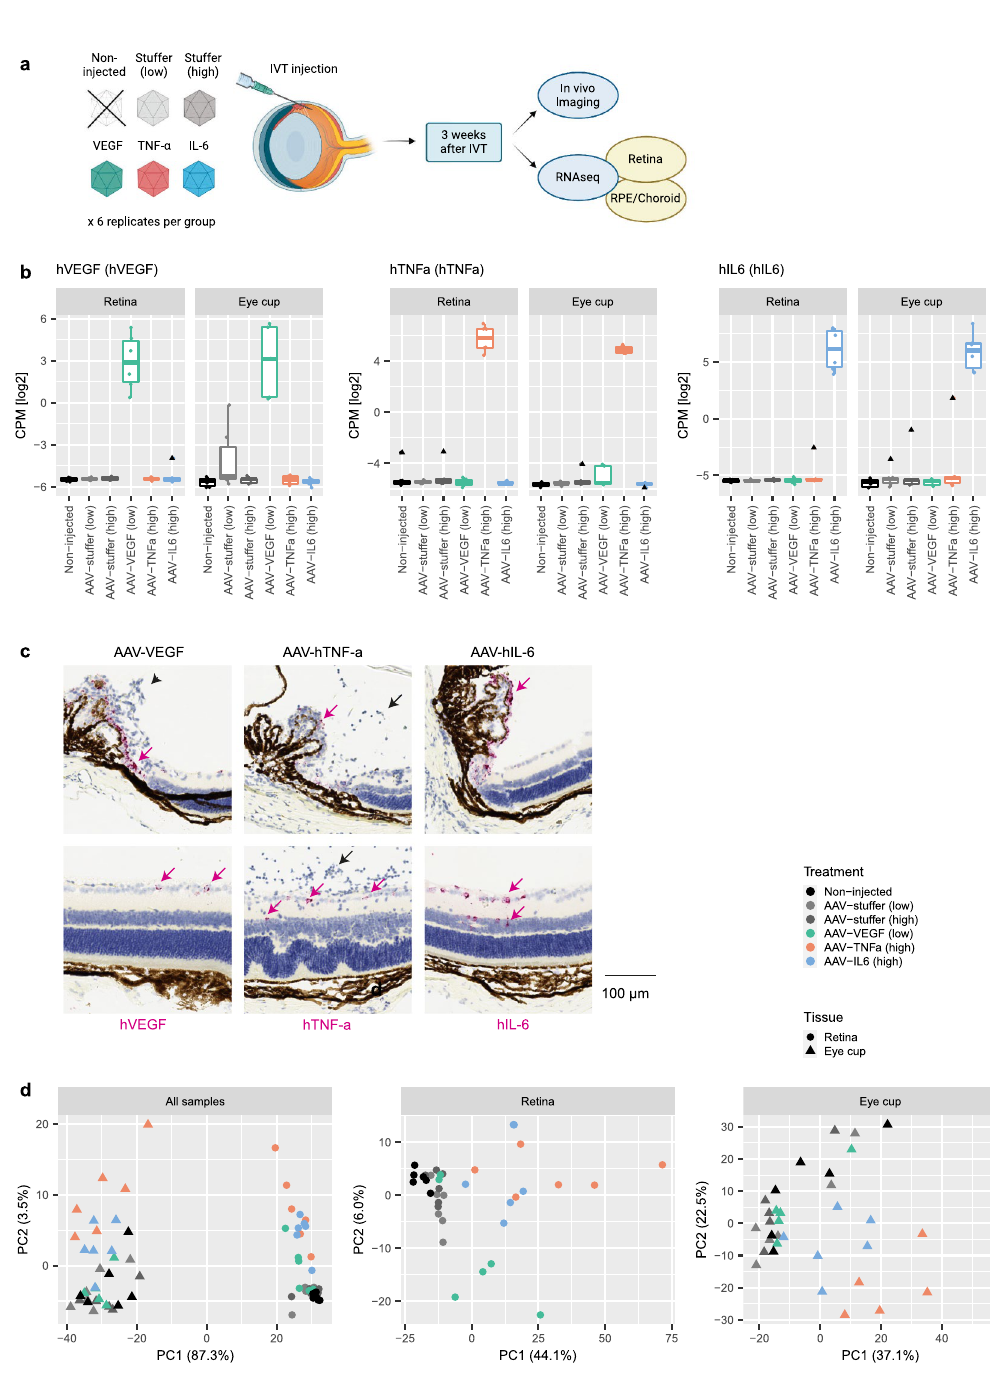
Figure 1. AAV-mediated expression of human VEGF, TNF-α, or IL-6 leads to distinct transcriptome changes. ( a ) Experimental design: Retina and eye cup tissue for RNA sequencing from 6 treatment groups (Non-injected, AAV-stuffer low, AAV-stuffer high, AAV-VEGF, AAV-TNF-α, and AAV-IL-6) were collected 3 weeks after IVT and in vivo imaging. The image was generated using BioRender. ( b ) Specific expression of human transgenes VEGF, TNF-α, and IL-6 in the respective treatment groups in both retina and eye cup tissue (CPM: Counts Per Million). ( c ) In situ hybridization using RNAscope technology demonstrated expression of the three human transgenes (pink arrows) in the ciliary body (upper panel) and the inner layer of the central retina (lower panel). Note the abnormal endothelial cells around the ciliary body in AAV-VEGF treated eyes (black arrowhead) and the infiltrating immune cells in AAV-TNF-α treated eyes (black arrow). ( d ) PCA demonstrated large differences between tissues (upper panel) and specific changes induced by VEGF, TNF-α, and IL-6, respectively, within each tissue (lower panels). Low dose = 1 × 10 8 VG/eye; High dose = 1 × 10 9 VG/eye. Percentage of variance explained by the two first principal components is shown together with the respective x- and